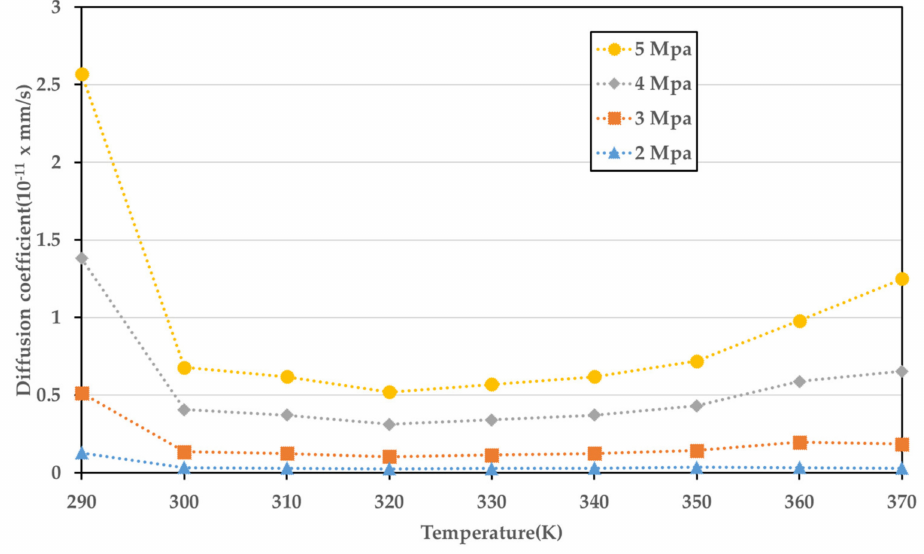
Figure 10. Diffusion coefficient of the desorption process at various